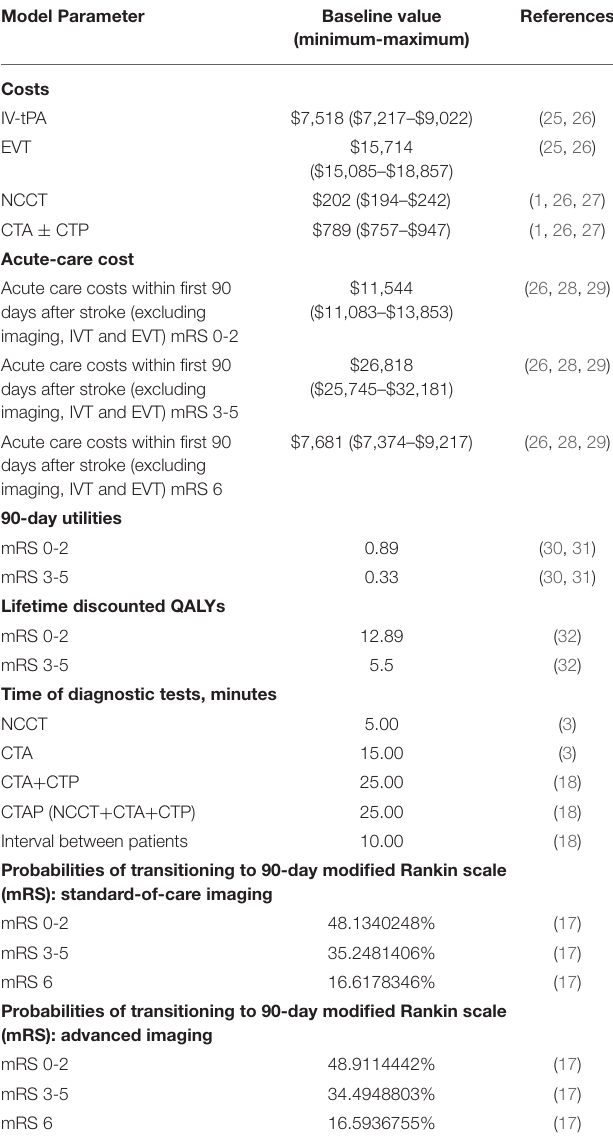
TABLE 2 | Cost data with minimum and maximum values adjusted for inflation to reflect values in 2019U.S. dollars. Model